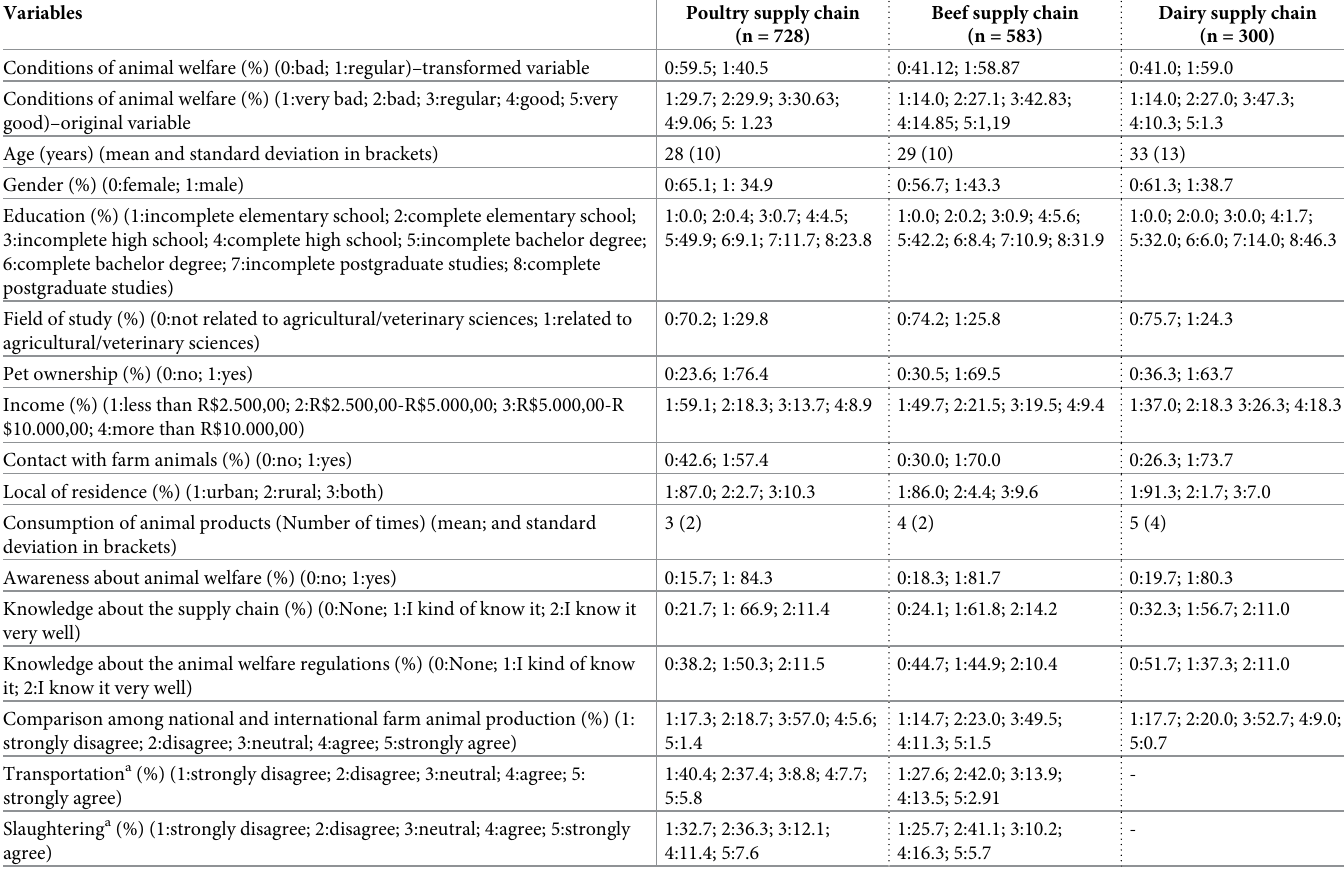
Table 1. Descriptive statistics of the variables used in the